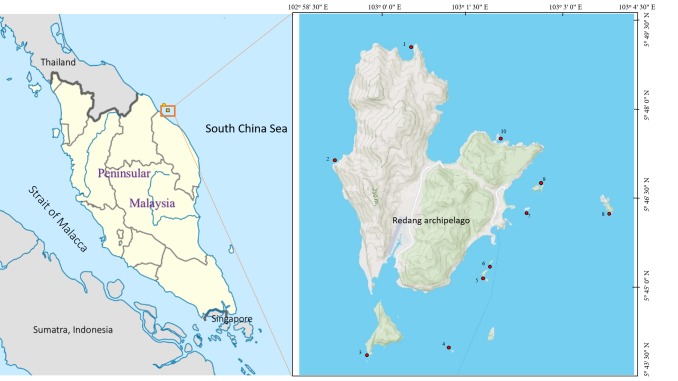
The map showing the location of Redang archipelago in the north Peninsular Malaysia, the inset map showing the survey locations.